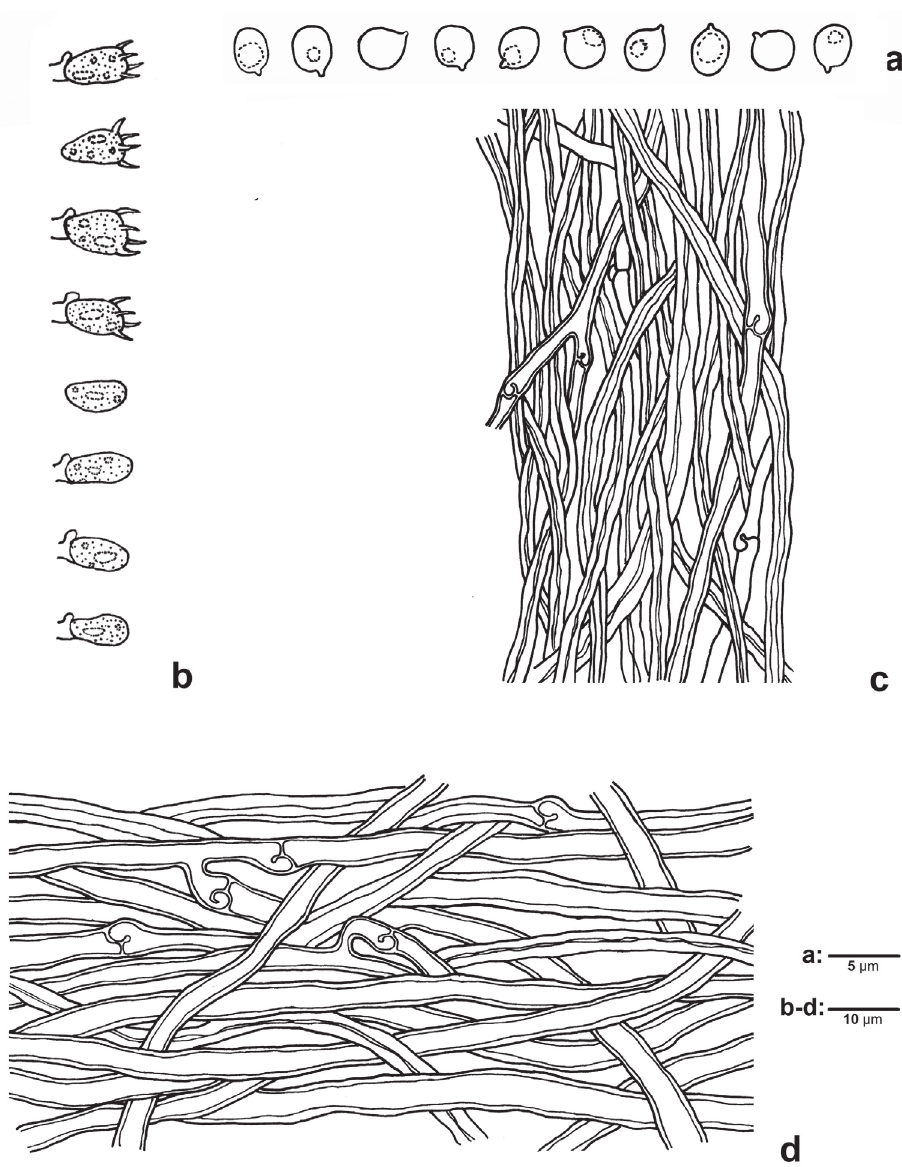
Figure 5. Microscopic structures of Trullella conifericola (IFP 019372, holotype) a basidiospores b ba- sidia and basidioles c hyphae from trama d hyphae from